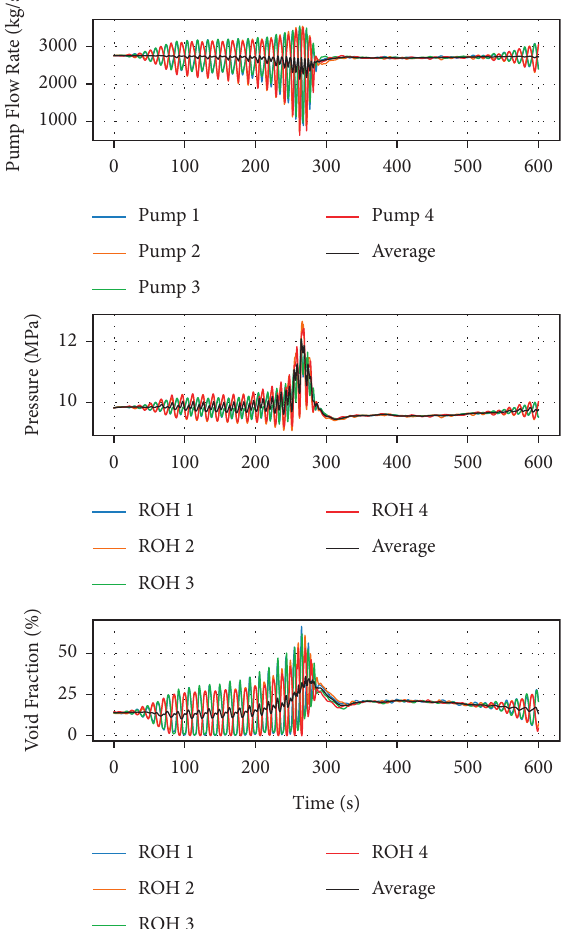
Figure 22: Flow rate oscillations at 108% full power with blocked header interconnects. The even pair of pumps and headers oscillate out-of-phase with the odd